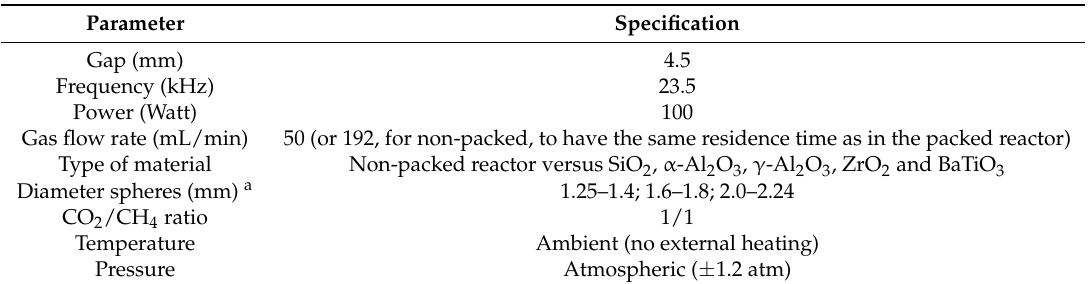
Table 5. Operating conditions and materials used in this